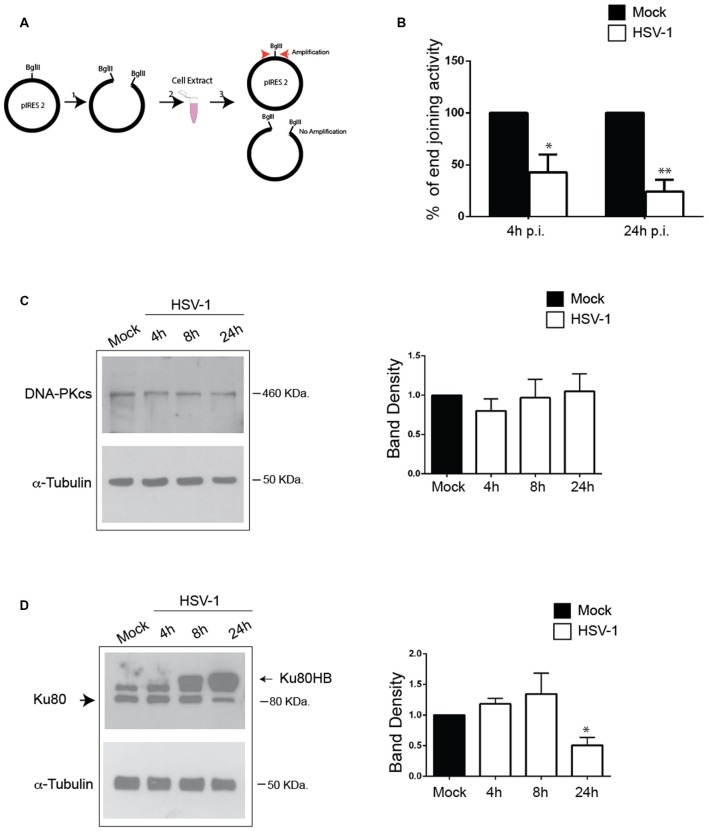
HSV-1 impairs non-homologous end joining (NHEJ) activity and modulates Ku80 expression in cortical neurons. (A) Schematic representation of the in vitro NHEJ assay used in panel (B). (B) Cell extracts harvested 4 and 24 h p.i. from Mock-or HSV-1-infected neurons were incubated with pIRES2 plasmid previously linearized by enzymatic digestion. Real-Time PCR amplification was used to reveal rejoining of the linearized plasmid. Percentage of end joining activity in HSV-1-infected extract vs. Mock-infected ones are shown as mean ± standard error of the mean (SEM) from three experiments: *p < 0.05, **p < 0.01 vs. Mock. (C,D) HSV-1 infected (10 m.o.i.) cortical neurons were lysated at the indicated time p.i. and immunoblotted with (C) anti-DNA-PKcs or (D) anti Ku80 antibodies, and for α-tubulin as sample loading control. Representative blots are shown; graphs show the densitometric analysis of the immunoreacive bands corresponding to DNAPKcs and Ku80 (mean ± SEM from four independent experiments). Values represent the normalized fold changes in protein levels after 4 h, 8 h, and 24 h from HSV-1 infection with respect to Mock infected cells. *p < 0.05 vs. Mock.